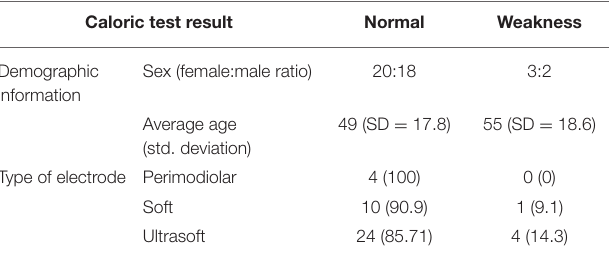
TABLE 3 | Caloric test postoperative